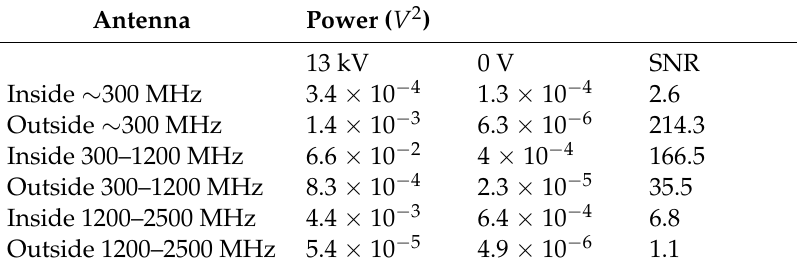
Table 6. Accumulated power and SNR for internal PD in Nomex inside the tank when measured with the inner and outer monopoles of 10